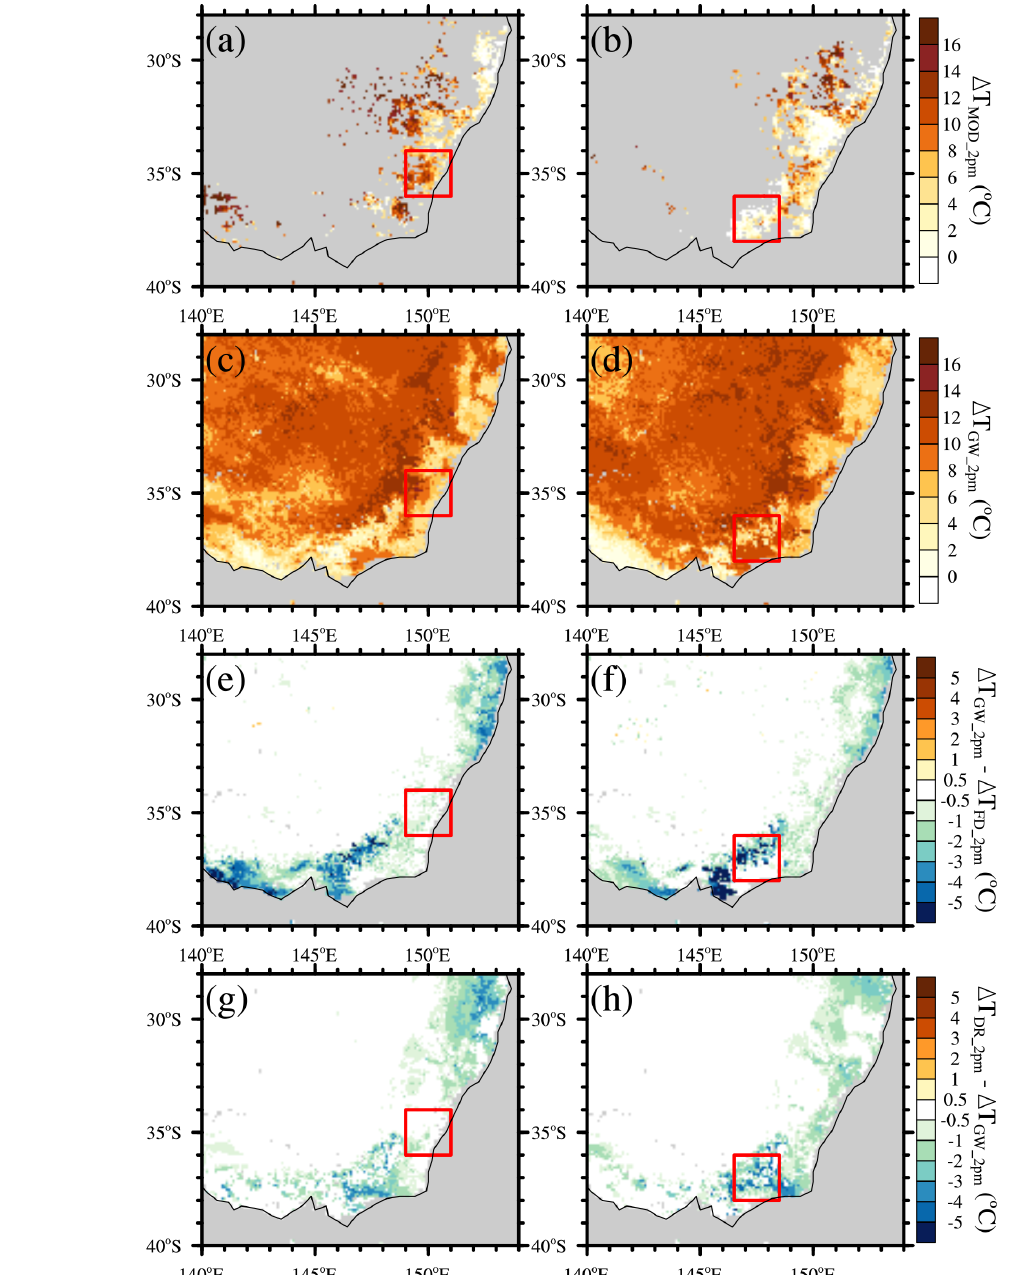
Figure 6. The simulation of two heatwaves on 15 (left column) and 25 January 2019 (right column). The first row shows the difference between MODIS land surface temperature (LST) and T air at 14:00 ( (cid:49)T MOD_14 : 00 ) (only forested areas with good LST quality data are displayed). The second row is the GW simulation of (cid:49)T at 14:00 ( (cid:49)T GW_14 : 00 ). The third row is the difference of (cid:49)T at 14:00 between GW and FD simulations ( (cid:49)T GW_14 : 00 − (cid:49)T FD_14 : 00 ). The last row is the same as the third row but for the difference between the DR and GW simulations ( (cid:49)T DR_14 : 00 − (cid:49)T GW_14 : 00 ). Note that the comparison between GW/FD/DR and MODIS LST is shown in Fig. S7.